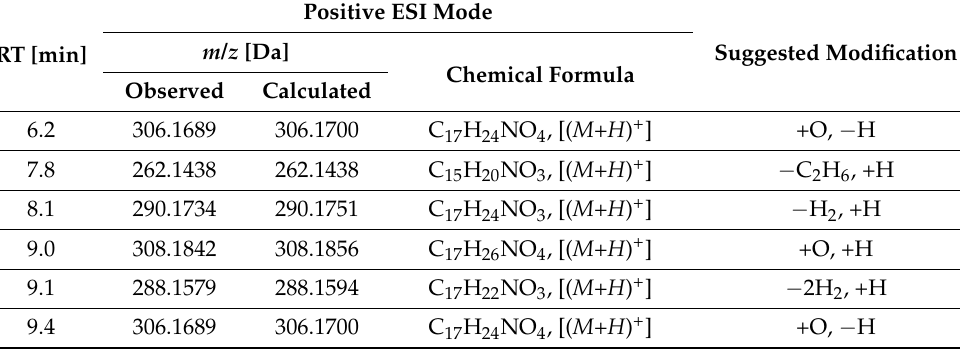
Table 4. HPLC-HRMS characteristics of the main products observed in the incubation of nitroxide